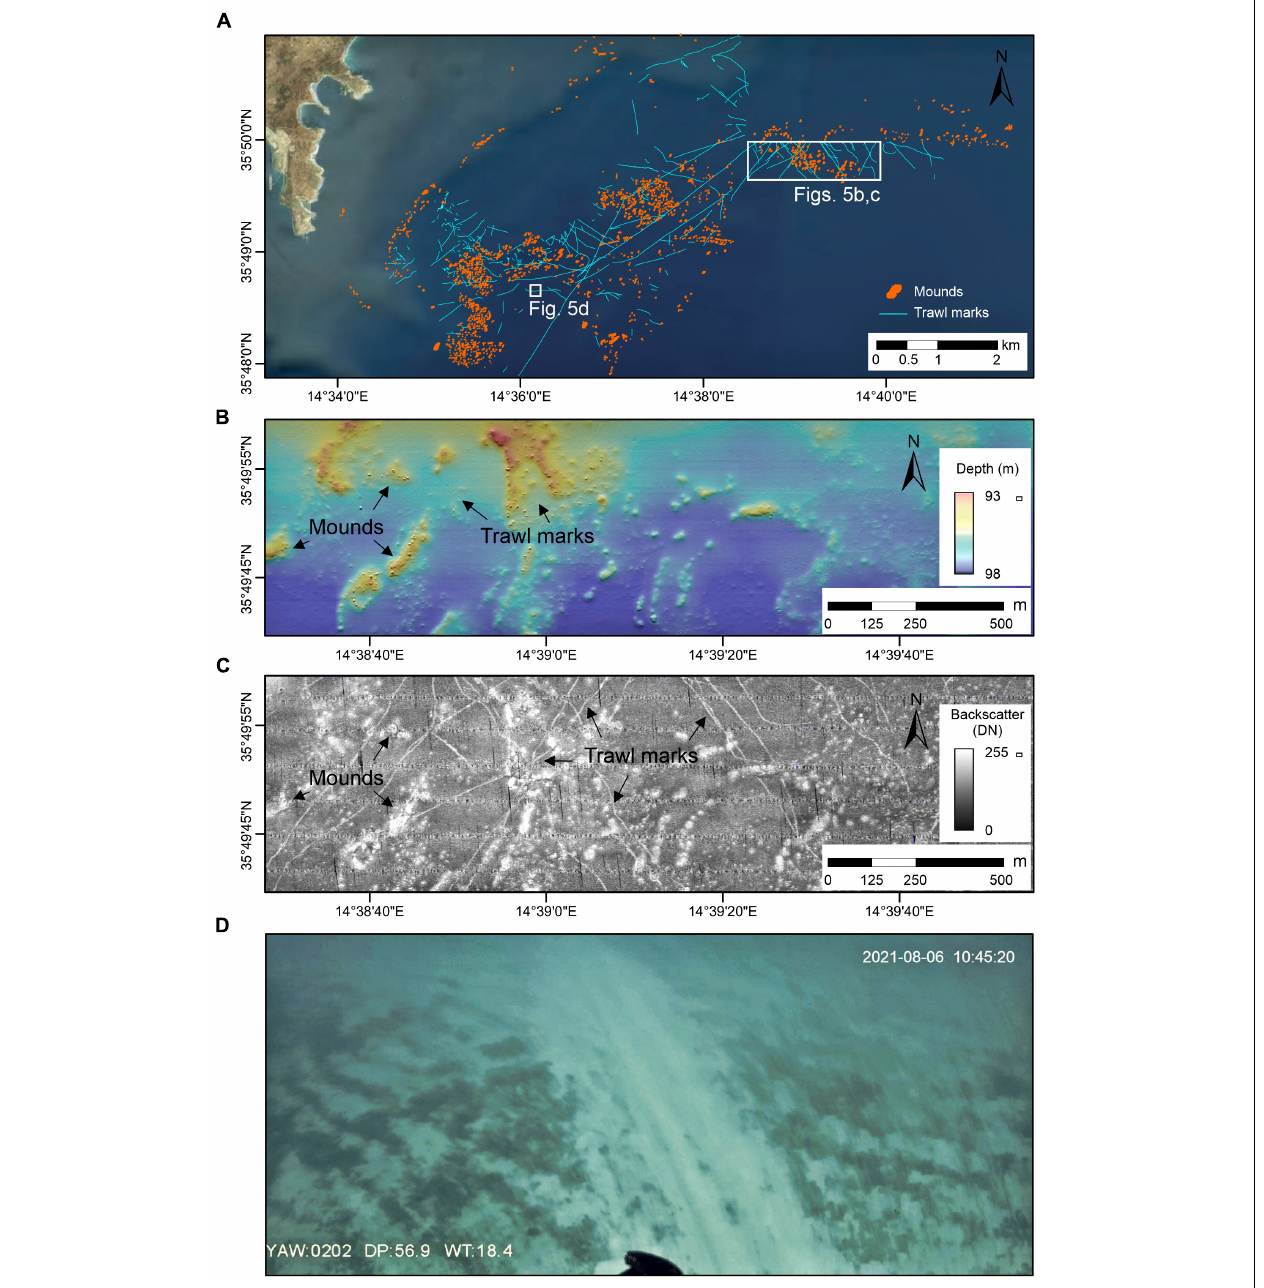
FIGURE 5 | Evidence of trawl marks in the study area. (A) Map showing trawl marks occurrence in the study area. (B) Shaded-relief color multibeam bathymetry and (C) backscatter imagery of an area of mounds highly impacted by trawling; (D) ROV image of a trawl mark probably caused by a trawl